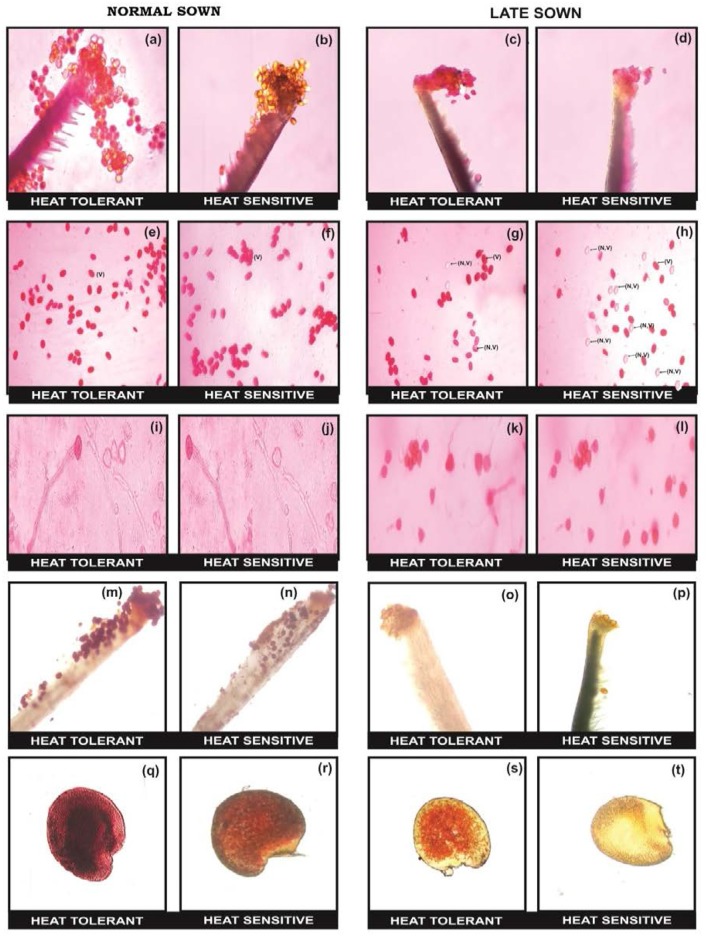
Comparison of reproductive biology attributes in normal sown (NS) and late sown (LS) lentil plants. Pollen load in (a,b) NS and (c,d) LS plants. Pollen viability [viable (V) and non-viable (NV) pollen grains] from (e,f) NS and (g,h) LS plants. In vitro pollen germination in (i,j) NS and (k,l) LS plants. Stigma receptivity in (m,n) NS and (o,p) LS plants. Ovule viability in (q,r) NS and (s,t) LS plants. Note marked reduction in (d) pollen load, (h) pollen viability, (i) pollen germination, (p) stigma receptivity, and (t) ovule viability in LS heat-sensitive genotypes compared with heat-tolerant genotypes.